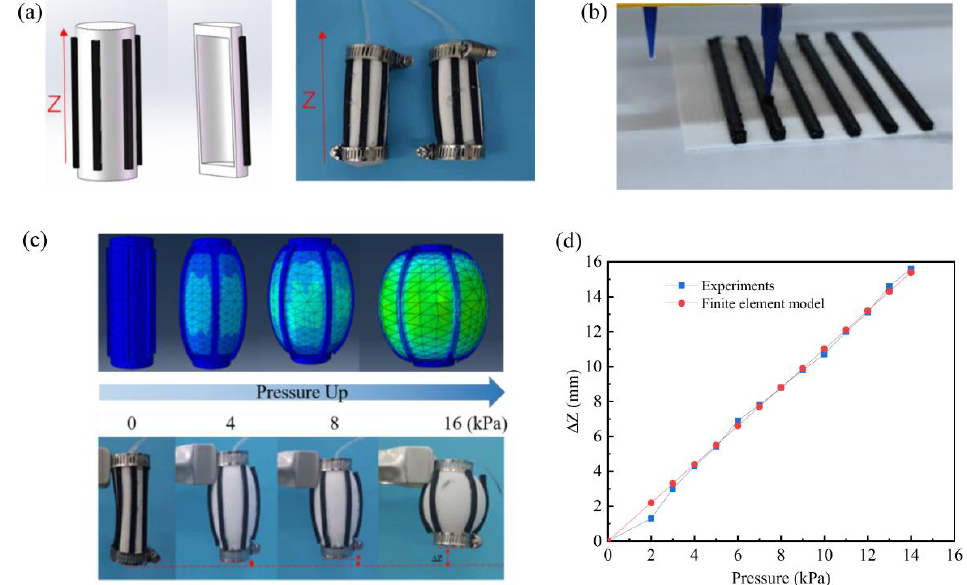
Figure 8. ( a ) Model of artificial muscle; ( b ) printing process of the artificial muscle; ( c ) equivalent elastic strain and actual experimental shapes of the artificial muscle; ( d ) axial contraction under different pressures obtained by the finite element model and